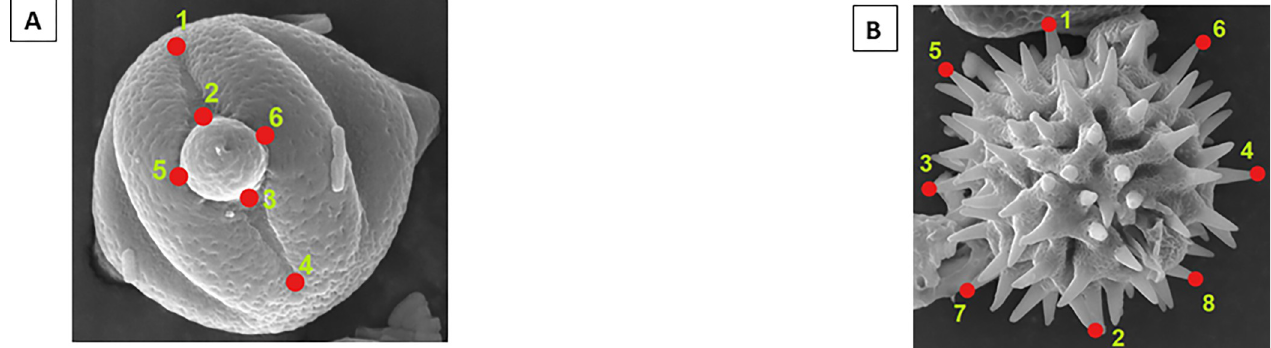
Fig 4. Morphometric geometry methodology. A) Selected anatomical points for pollen from family Melastomataceae, genus Miconia ; B) Selected anatomical points for pollen from family Asteraceae, genus Bidens . In the figures above each red point represent the specific position (coordinates) of one landmark or anatomical point, that surrounding the area which were used as potential indicator of species differentiation for pollen grains that belongs to the same family and genus.